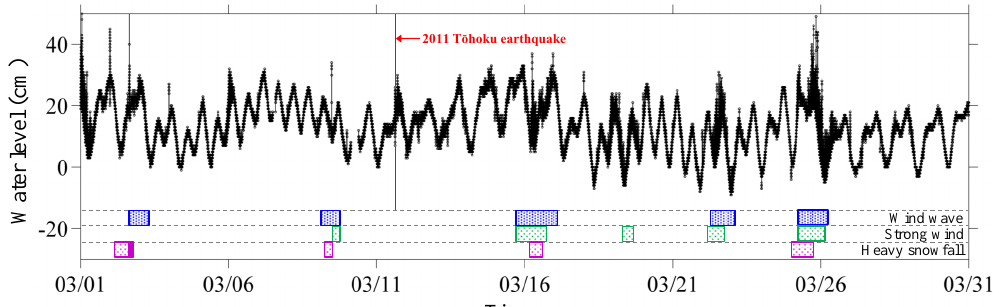
Figure 2. Time series of the Ulleung-do surge gauge with a special weather report from the KMA. The dotted rectangles represent the following advisories: wind wave (blue), strong wind (green), and heavy snow (purple). The filled rectangle represents a heavy snow warning (purple). The red vertical line labeled “2011 T¯ohoku Earthquake” denotes the time of the earthquake.